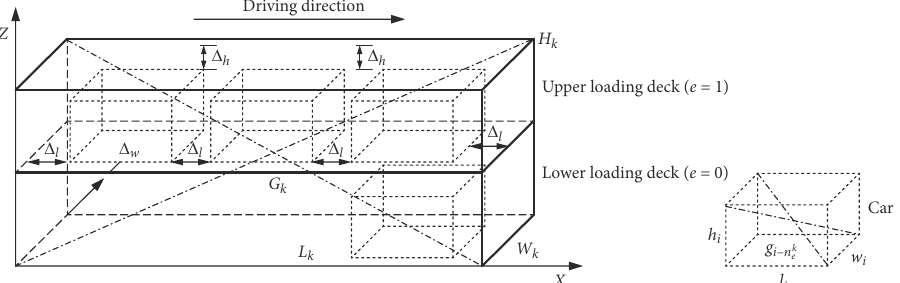
Figure 1. Loading illustration of both decks in a